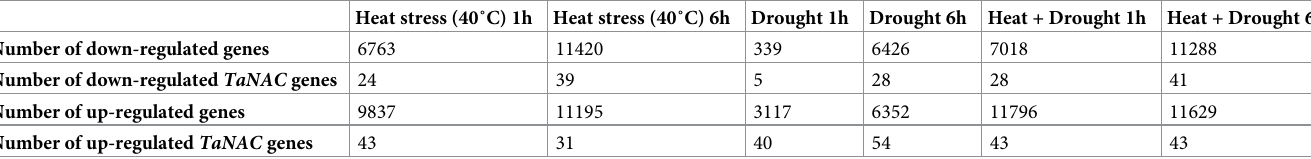
Table 1. Number of differentially expressed genes in response to two abiotic